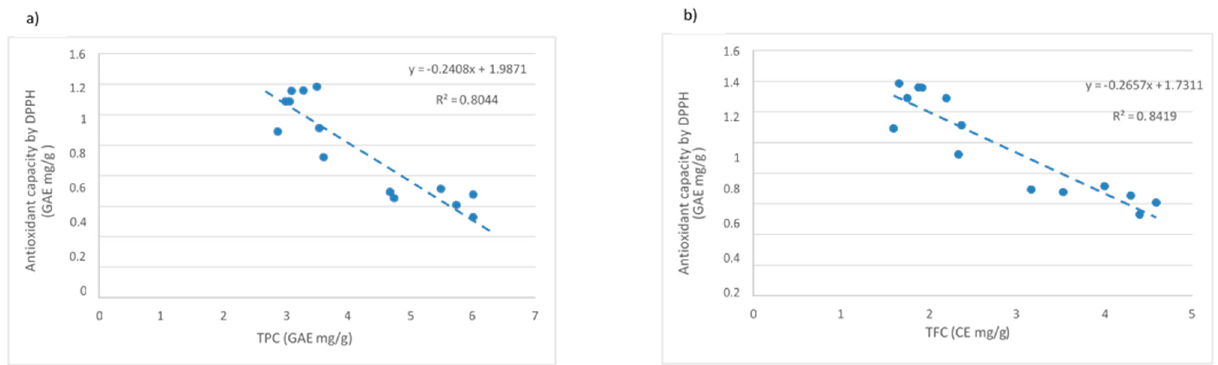
Figure 4. Correlation between ( a ) TPC and ( b ) flavonoid content with antioxidant activity tested by DPPH assay.